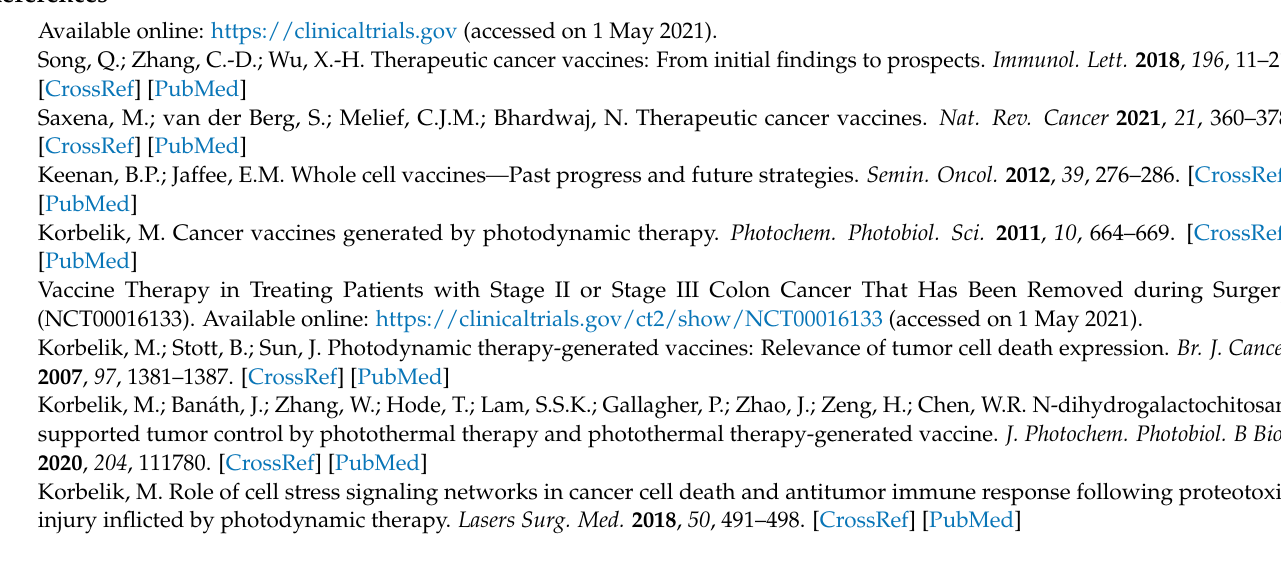
Blocking antibodies were, in all cases, used at 30 µ g/mouse i.p. and administered 30 min before vaccination. # All tumors growth-inhibited; * Tumor growth retardation less pronounced than with vaccine alone group; & No significant tumor growth